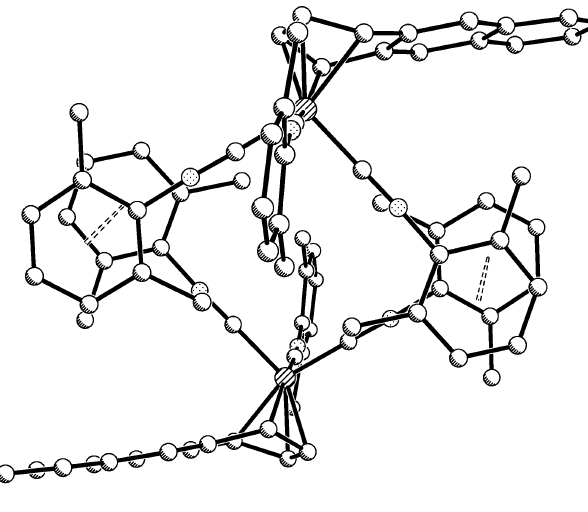
Figure 5 Depiction of the offset parallel (cid:5) – (cid:5) interactions between two molecules of 1 whose centroid–centroid (dashed lines) distances are 3.59 A˚ . The second molecule is generated by inversion operator 1 (cid:2) x , 1 (cid:2) y , (cid:2) z